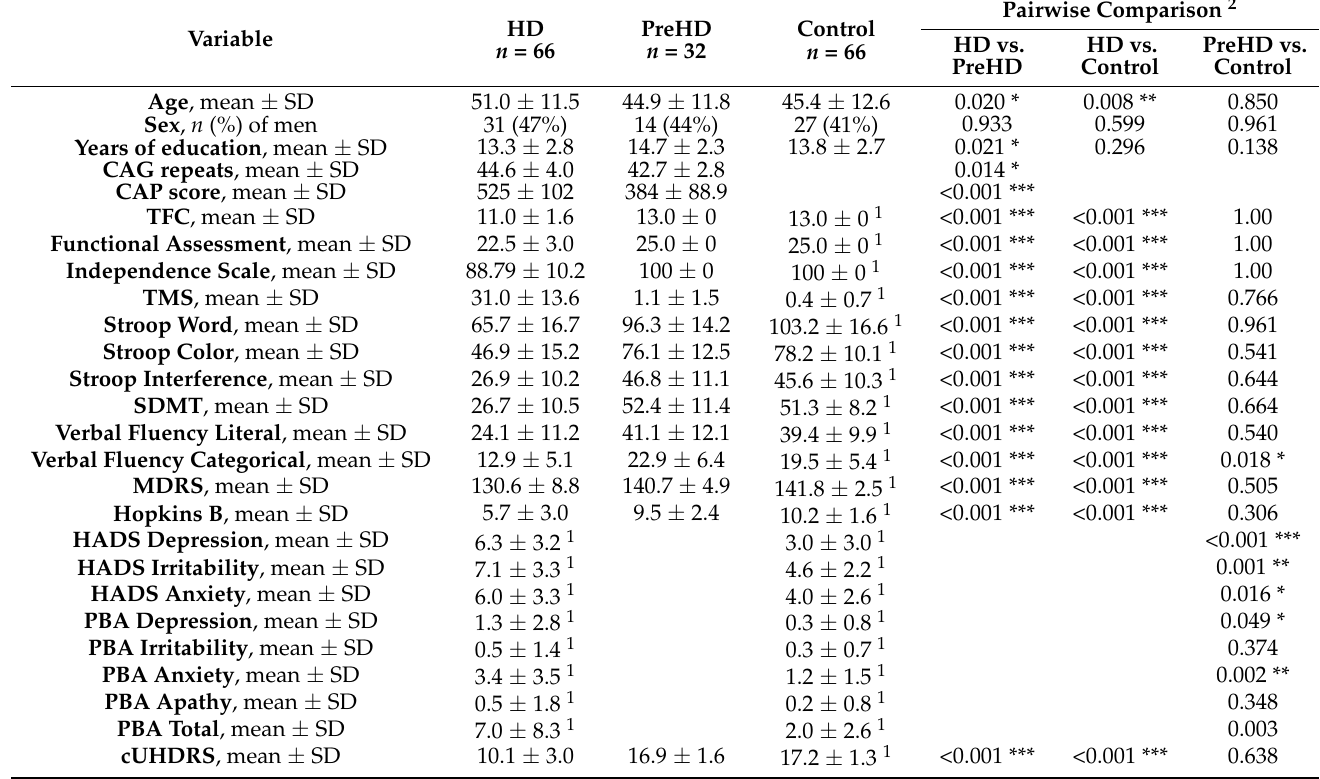
Table 1. Description of